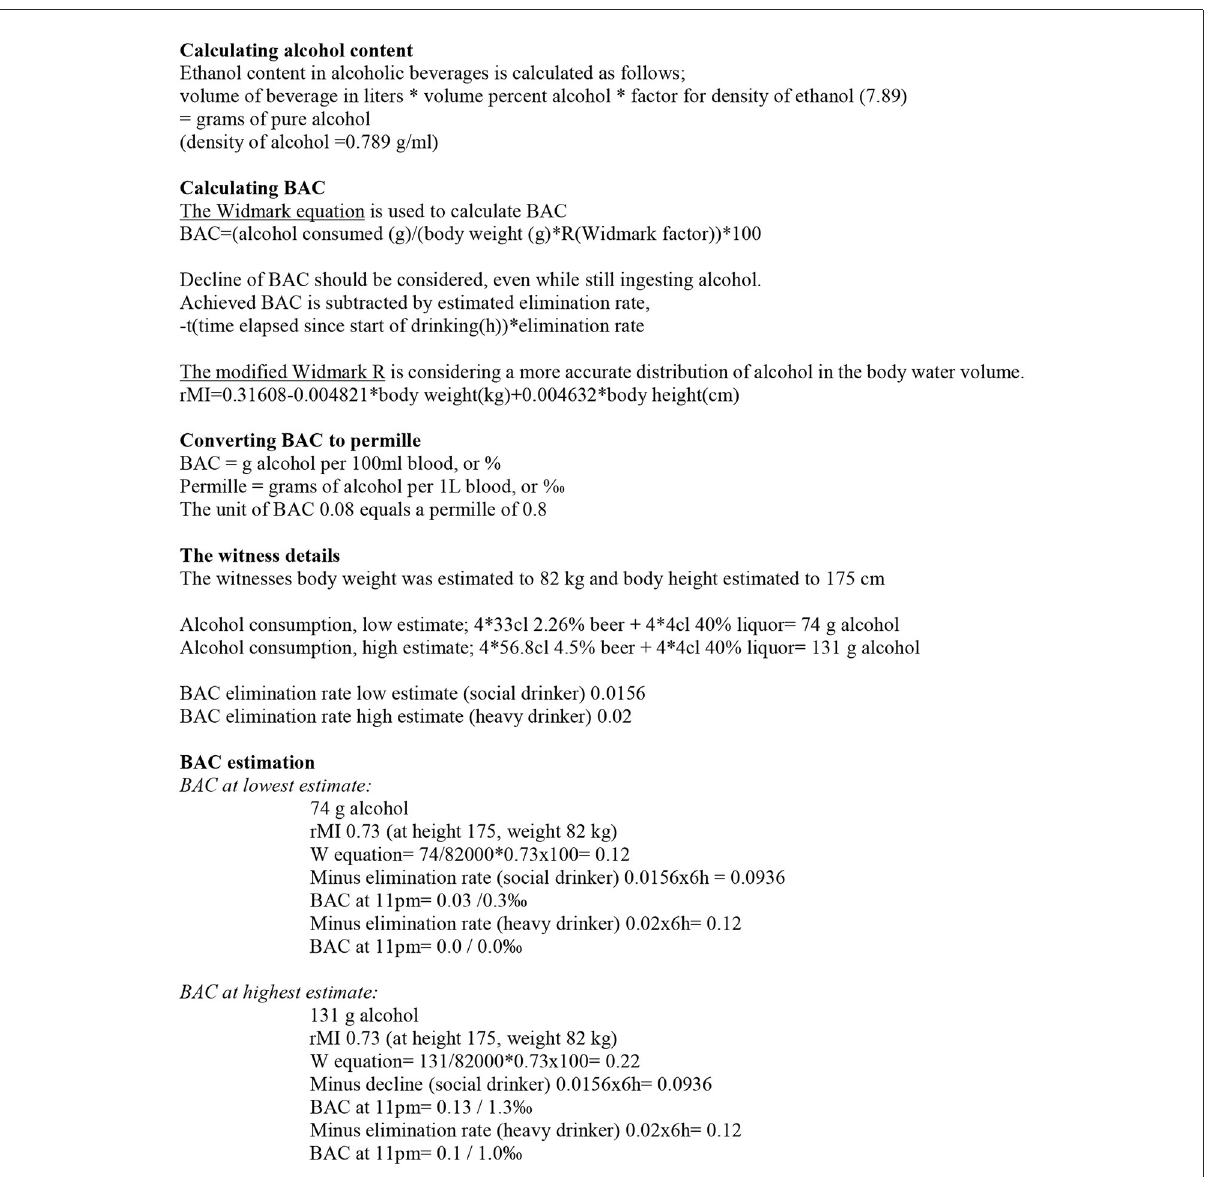
FIGURE2 Calculation of possible